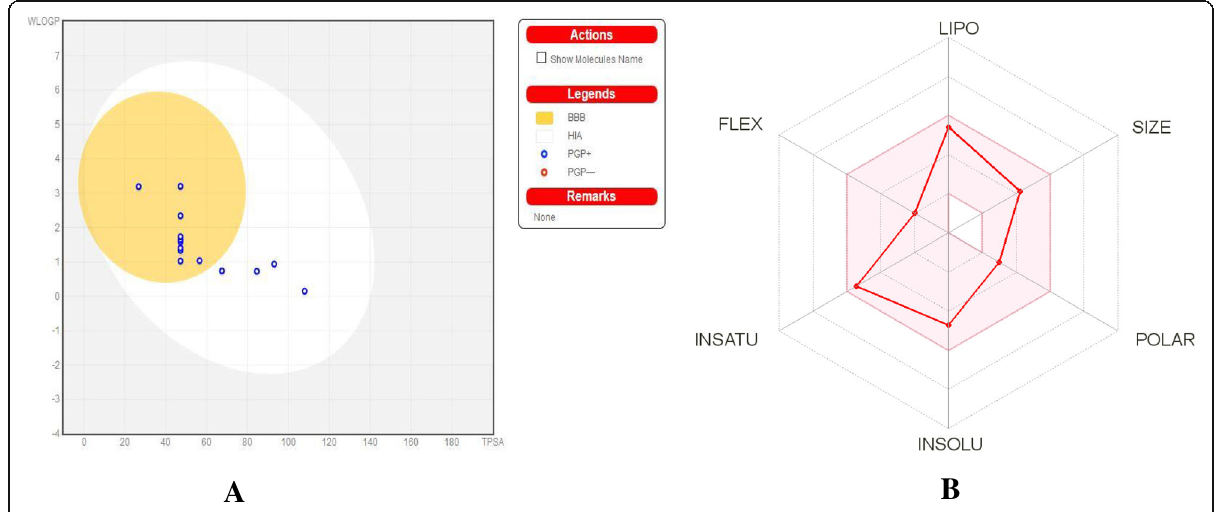
Fig. 4 a BOILED-Egg diagram for all the designed compounds including the referenced drug and b bioavailability radar chart for compound 39g